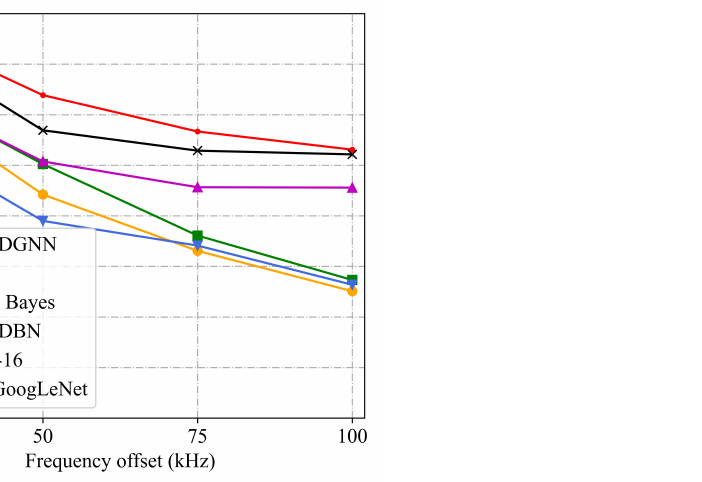
Figure 7. Performance comparison on real measured signal at different frequency offsets when the SNR is − 5 dB.